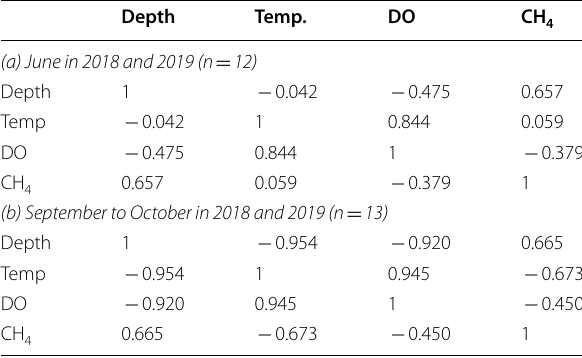
Principal component statistics and raw data profiles are shown in the Fig. 3b and Table 6, respectively